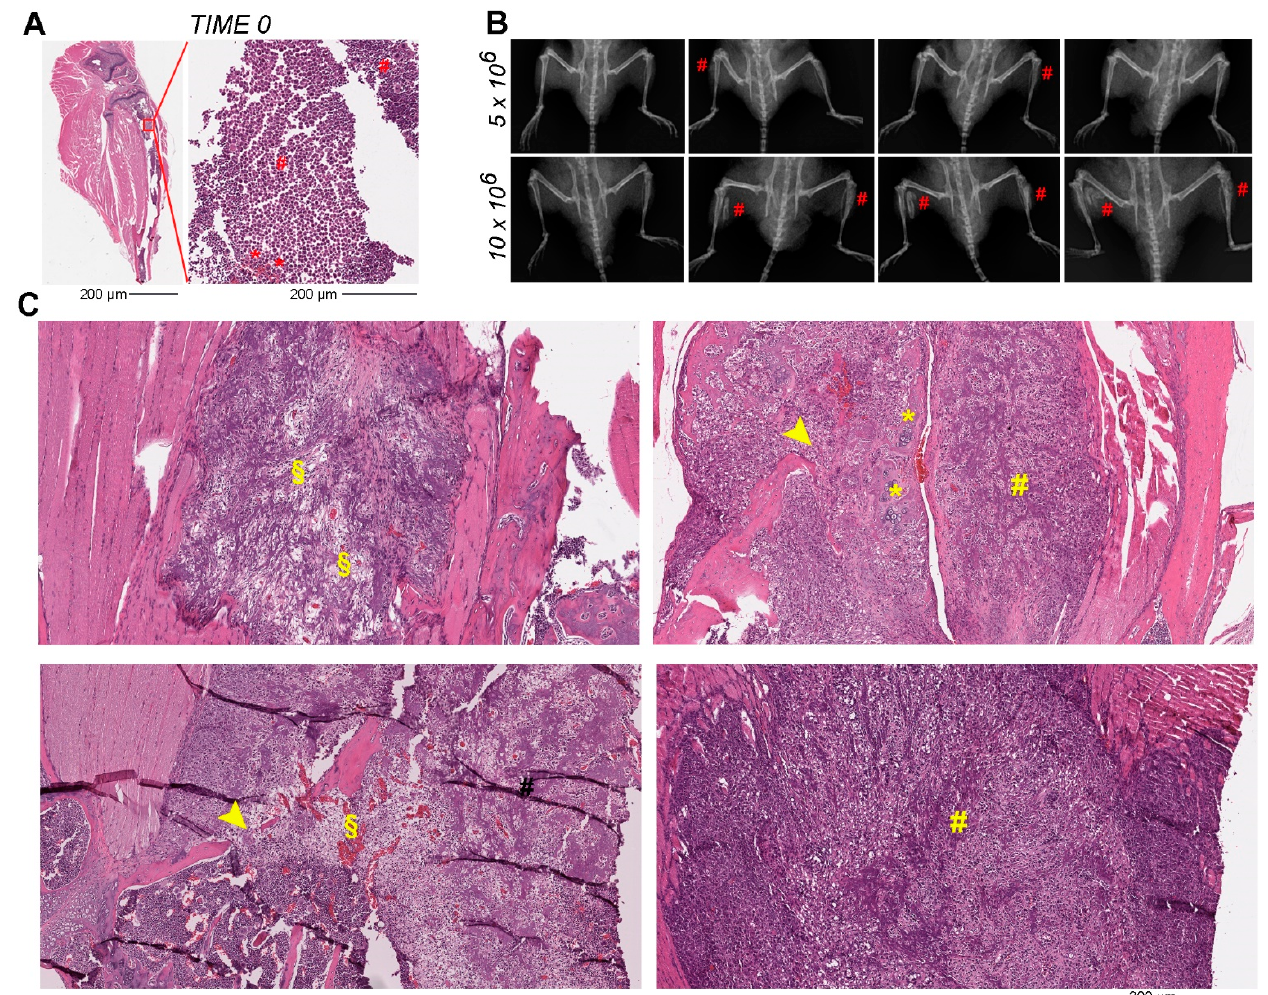
Figure 3. Preclinical Osteosarcoma mouse model set up. ( A ) Representative paraffin section stained with H&E showing the entire tibia right after the inoculation of Saos-2 cells (TIME 0). The magnification of the red squared area is shown in the right panel. The red hash marks (#) indicate the OS tumor cells, while the red asterisks (*) the bone marrow cells. ( B ) Representative X-ray imaging of four animals from the 5 × 10 6 Saos-2 group at week 6 from initial inoculation, and of four animals from the 10 × 10 6 Saos-2 group at week 8 from initial inoculation. The red hash marks (#) point to the detectable tumor mass. ( C ) Representative paraffin sections stained with H&E of 10 × 10 6 Saos-2 inoculation groups at 8 weeks. The § indicates the necrotic area, the hash marks (#) indicate new bone matrix, the head-arrows indicate the bone trabeculae damage due to tumor growth, while the asterisks the chondroid matrix.